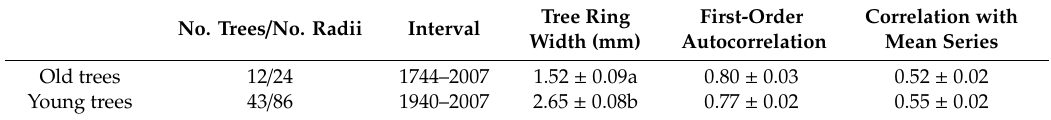
Table 1. Dendrochronological statistics of old and young Abies pinsapo trees. Values are means ± SE. Di ff erent letters indicate significant ( p < 0.05) di ff erences between old and young trees according to Mann-Whitney